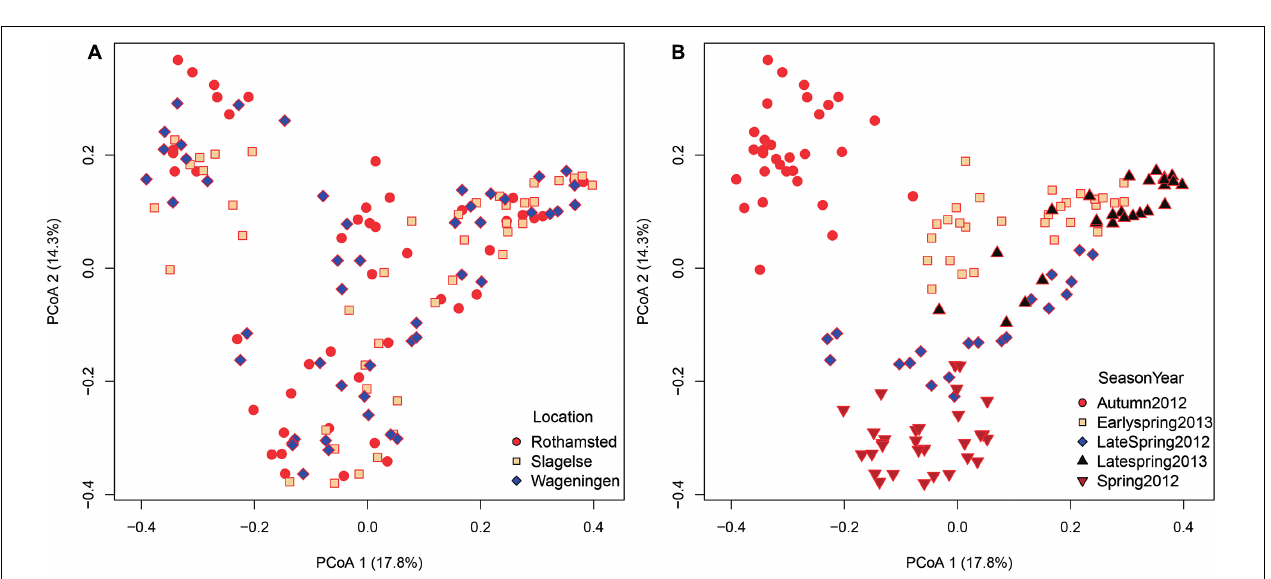
FIGURE 3 | Boxplots showing the number of observed operational taxonomic units (OTUs) for the different sampling periods. Each point represents samples, and upper, middle and lower lines represent first quartiles, medians and third quartiles. The whiskers represent a 1.5 ∗ inter-quartile range. Aut = autumn; Espr = early spring; LSpr = late spring; 12 = 2012; 13 = 2013; Rot = Rothamsted; Slg = Slagelse; Wag = Wageningen; X = Rothamsted oilseed rape field samples. n = number of samples.